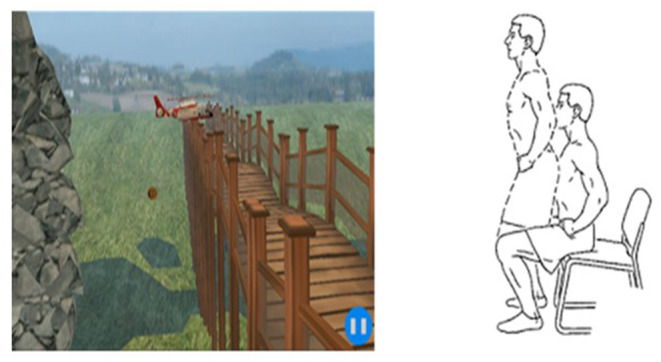
Sit to stand game through virtual reality.